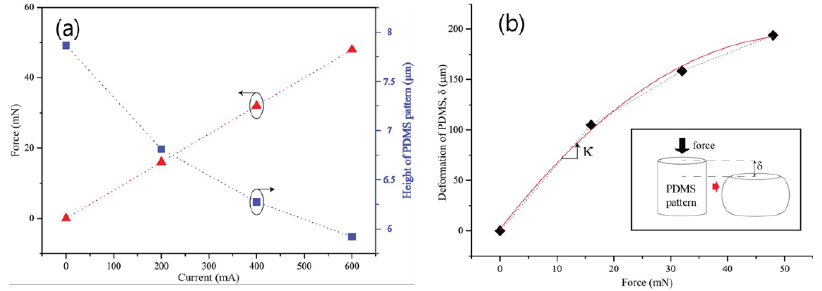
Figure 9. ( a ) Mechanical forces of solenoid and height of PDMS pattern as a function of current, and ( b ) deformation of PDMS as a function of the mechanical force of solenoid.